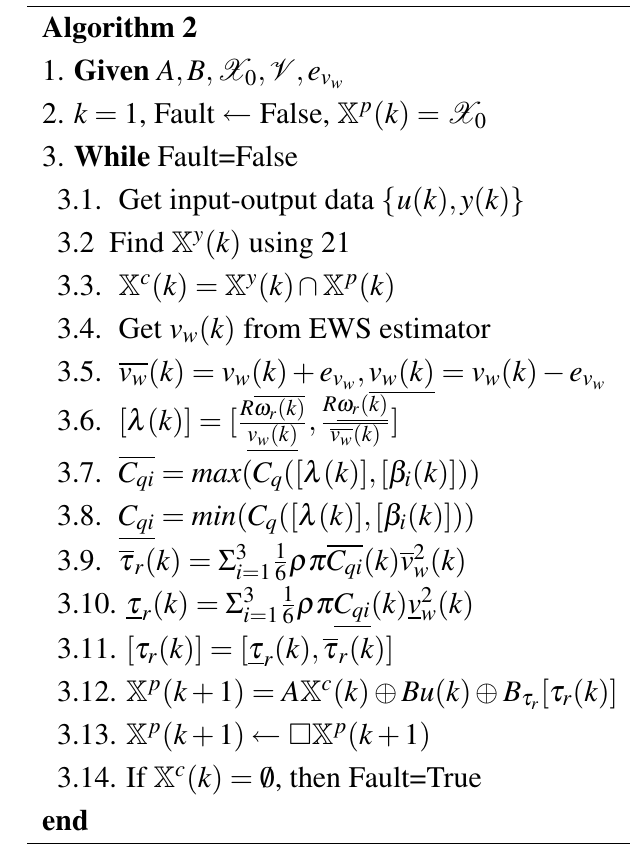
Table 5. State space set-membership fault